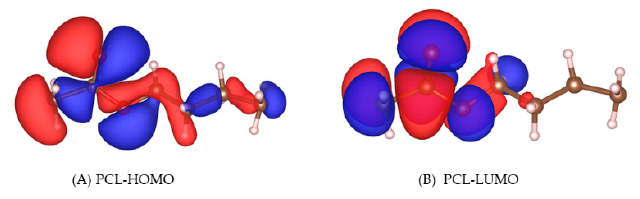
Figure 5. Charge-density difference of PCL on different HA surfaces.